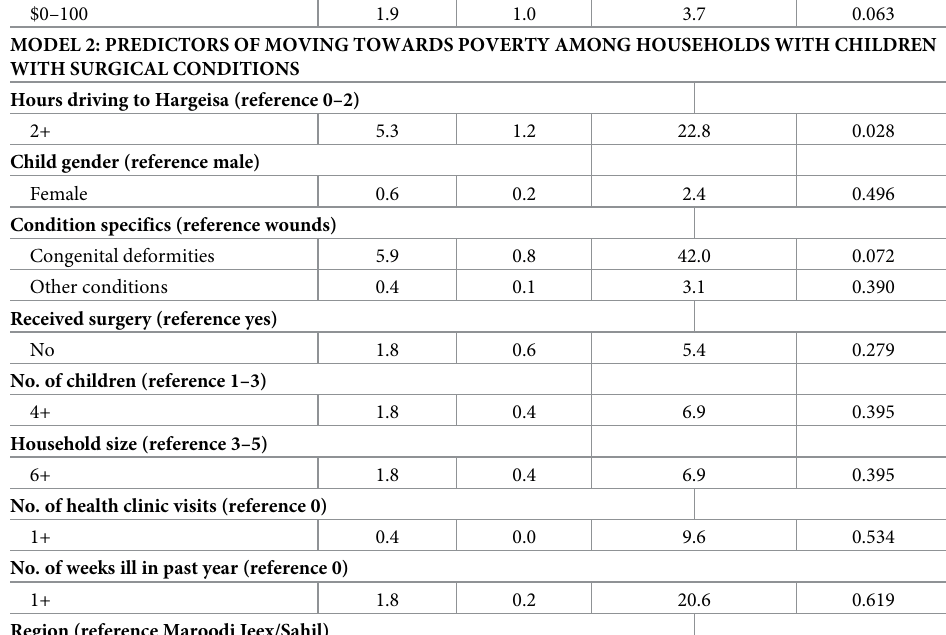
MODEL 2: PREDICTORS OF MOVING TOWARDS POVERTY AMONG HOUSEHOLDS WITH CHILDREN WITH SURGICAL CONDITIONS Hours driving to Hargeisa (reference